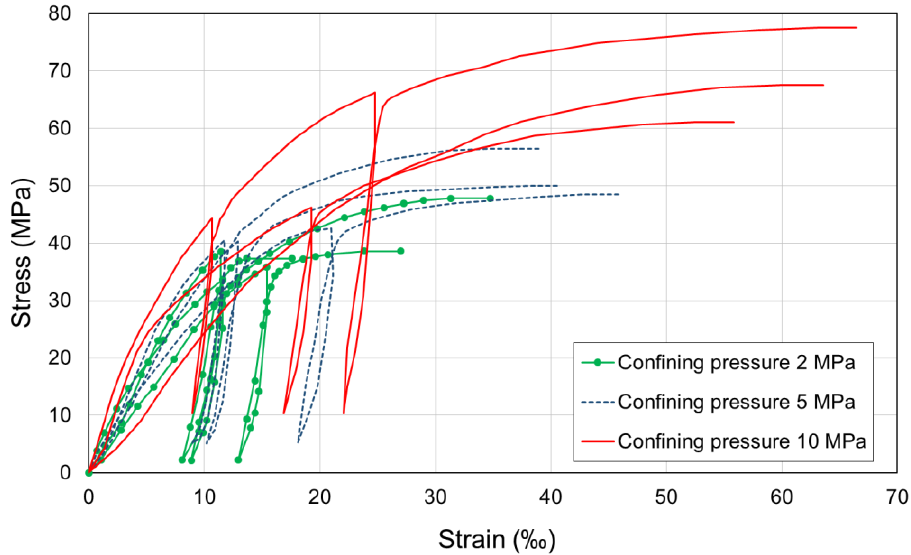
Figure 12. Stress–strain characteristics of the Red Zuber unit samples—conventional triaxial compression tests at a constant stress rate (according to [58]).